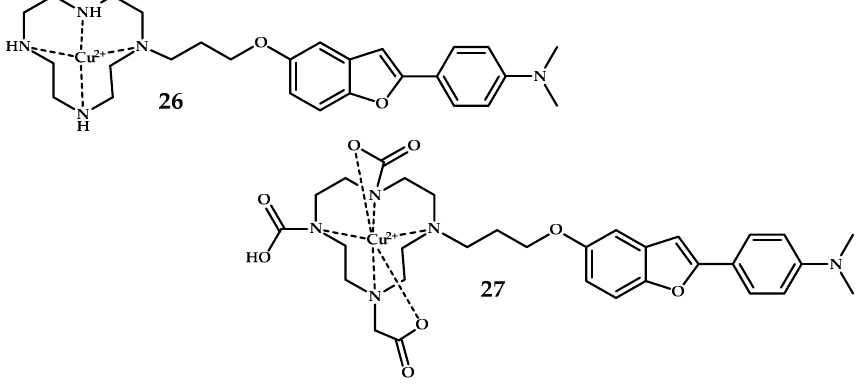
Figure 8. Benzofuran moiety, conjugated with metal-chelating cyclen 26 or 1,4,7,10- tetraazacyclododecane-1,4,7,10-tetraacetic acid (DOTA) 27 , designed for A β fibrils visualization.